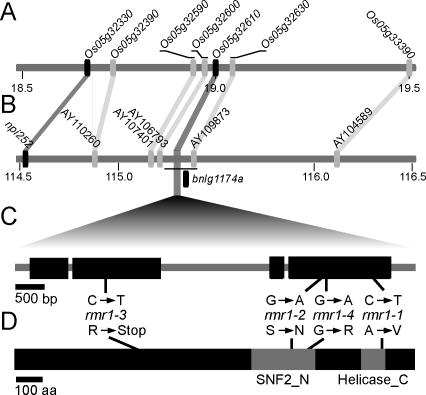
Map-Based Cloning of rmr1
(A and B) Rice Chromosome 5 (http://rice.tigr.org/) (A) and maize Chromosome 6 (B) (2005 FPC map, contig 285; http://www.genome.arizona.edu/fpc/maize/) with synteny of annotated rice loci and orthologous maize markers (gray boxes) highlighted. Black boxes indicate the rice rmr1 ortholog, Os05g32610, and the SSLP marker npi252. Neither rmr1 nor SSLP marker bnlg1174a are represented on the FPC map, though both can be amplified from a BAC (c0007N19), identified by GenBank accession AY109873, which maps to the region identified by the black line.(C) Gene structure of rmr1 with exons in black; EMS-derived mutations are noted.(D) Gray boxes highlight conserved Pfam SNF2_N (E-value = 1.3 × 10−8; amino acids 851 to 1214) and Helicase_C (E-value = 1.1 × 10−11; amino acids 1255 to 1334) profiles in the RMR1 protein. Predicted translational consequences of each rmr1 mutation are indicated.